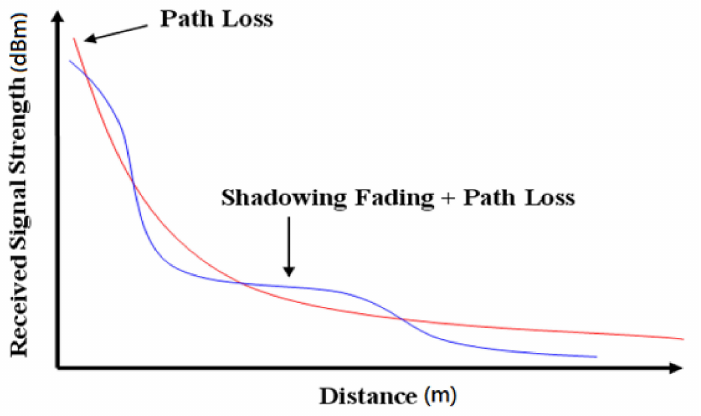
Figure 1. The relationship between electromagnetic wave propagation distance and signal strength.